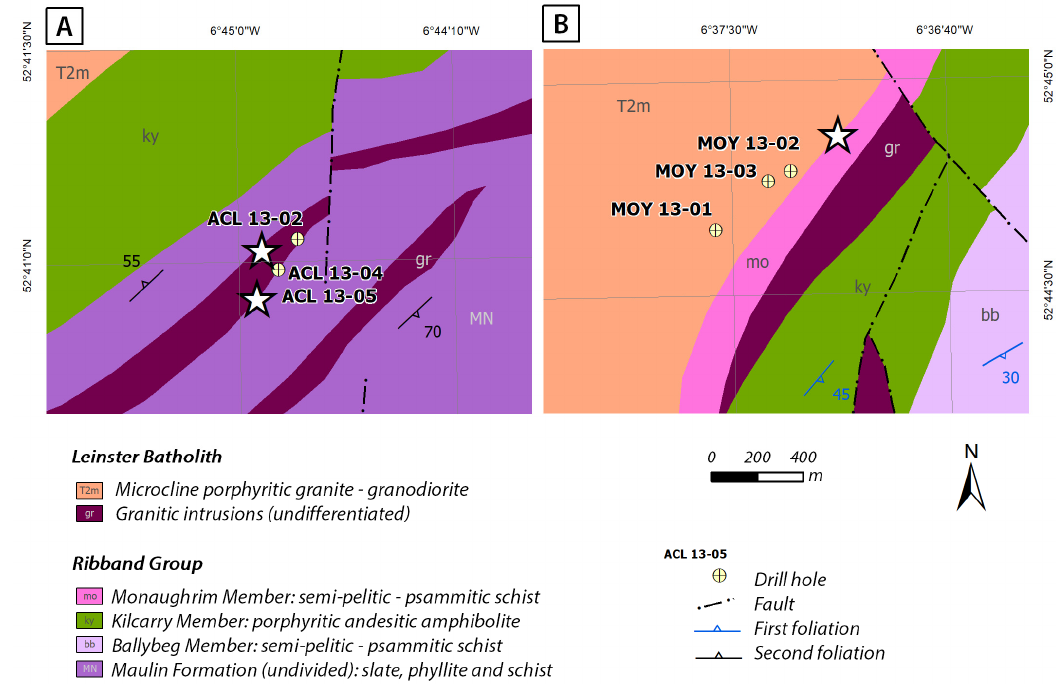
Figure 2. Location of drill collars studied in ( A ) Aclare and ( B ) Moylisha. Both areas represented are within the ECDZ. Geological units from the 1:500,000 geological mapping shapefiles of Geological Survey Ireland. White stars as in Figure